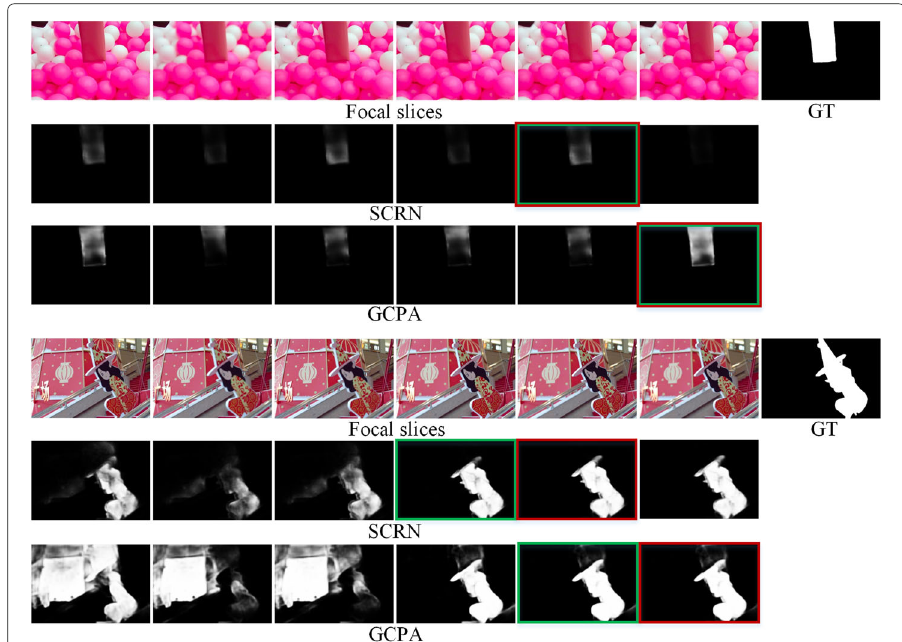
Fig. 9 Typical failure cases of the proposed method. GT denotes ground truth. Green boxes denote the slice selected by our method while the red ones denote the best slice by F